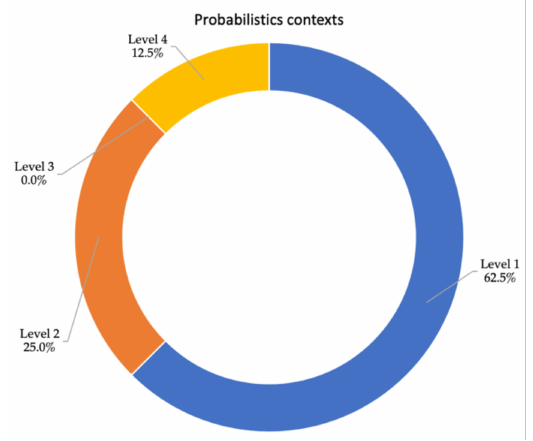
Figure 4. Probabilistic contexts by